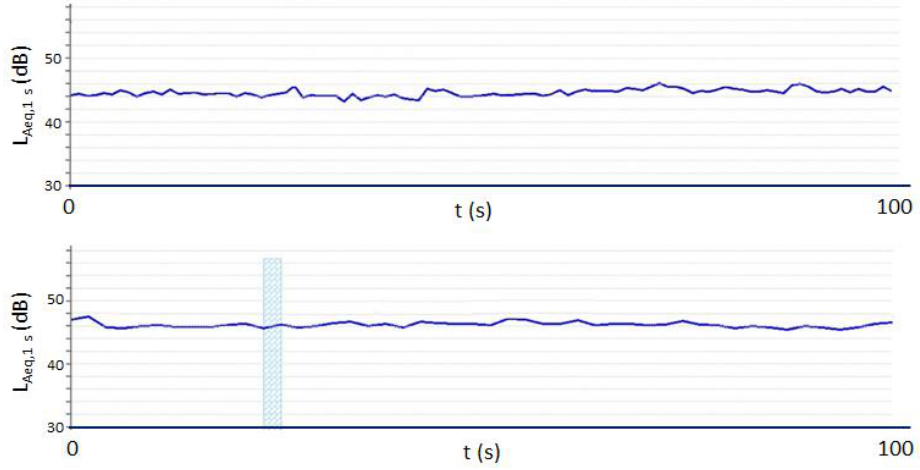
Figure 10. Sound pressure levels measured at measurement point #6, in the absence and presence of sound masking. The top image refers to the levels measured with the masking system turned off, while the bottom image refers to the levels measured under the effect of the masking system. The blue shaded area indicates a region that has been edited to remove the sound of a dog barking.